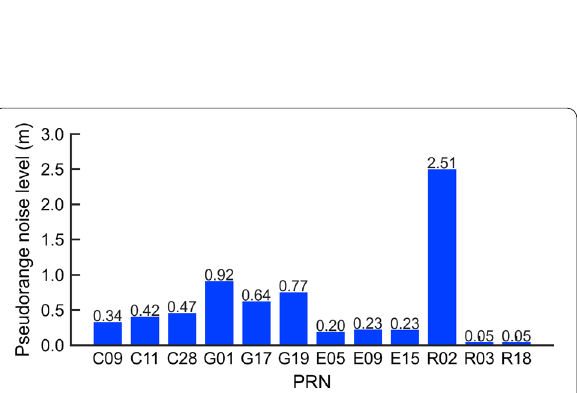
Fig. 12 Pseudorange noise levels of 12 BDS, GPS, Galileo and GLONASS